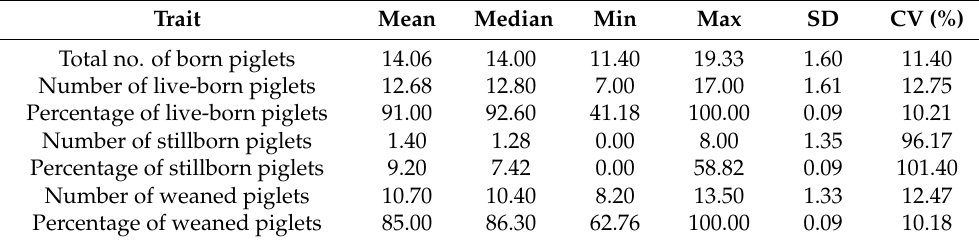
Table 6. Summary statistics of the traits related to litter size in the Polish Large White sows. Trait